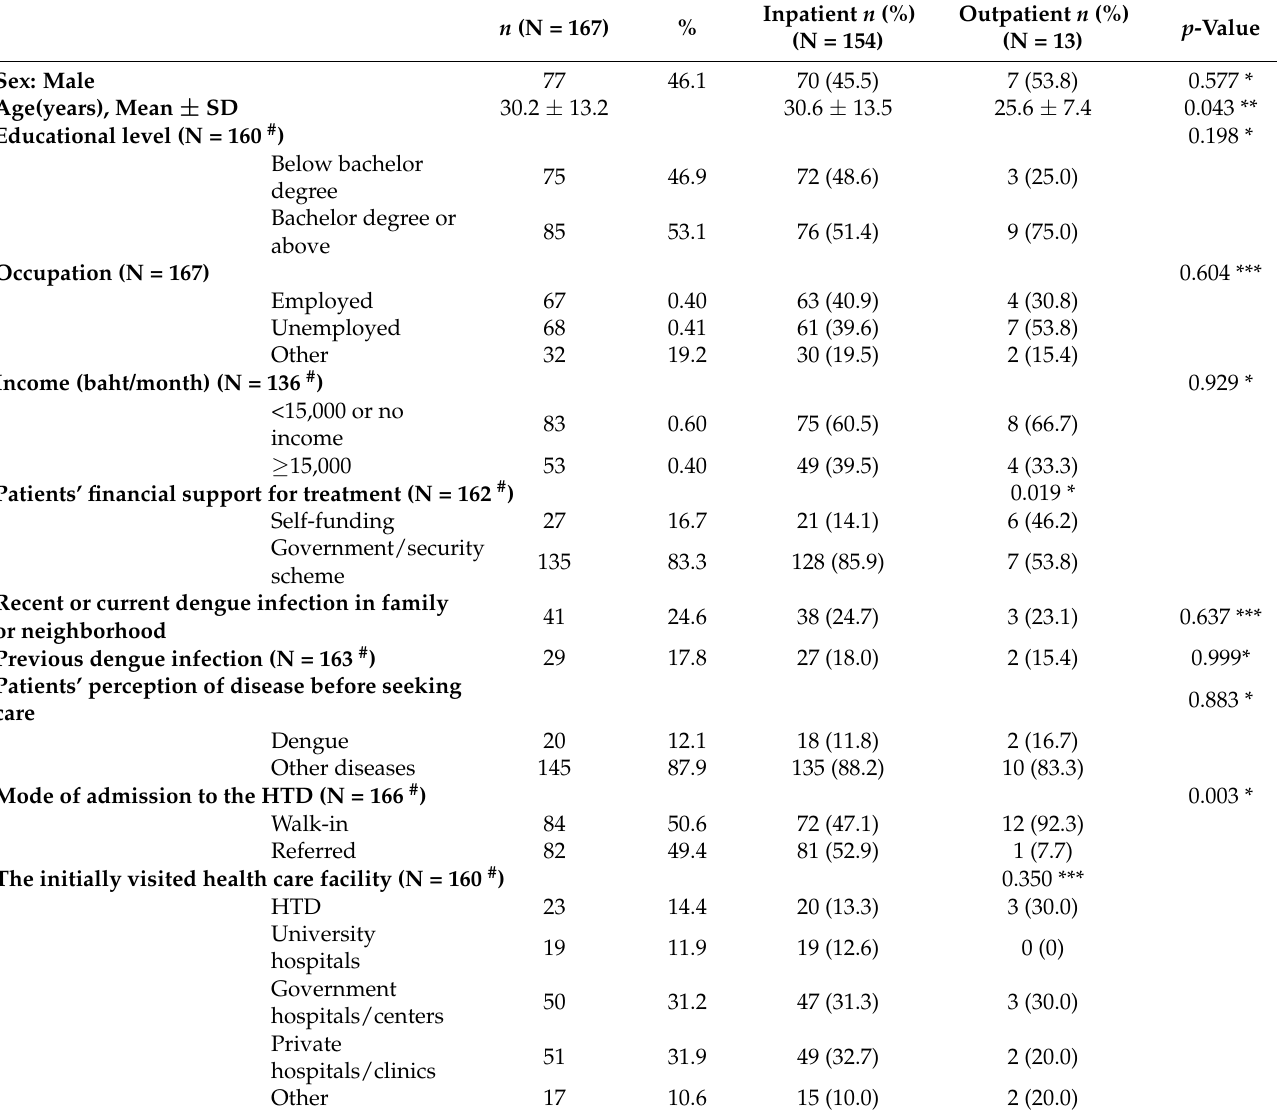
Table 1. Socio-demographic data of participants and their